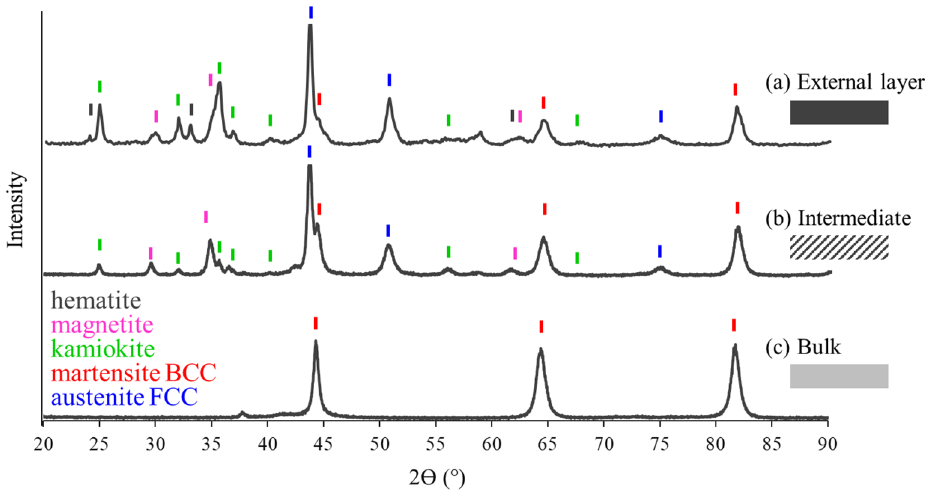
Figure 4. XRD profiles of each region at z direction. ( a ) external layer, ( b ) intermediate layer and ( c ) Bulk. ( c ) Bulk.